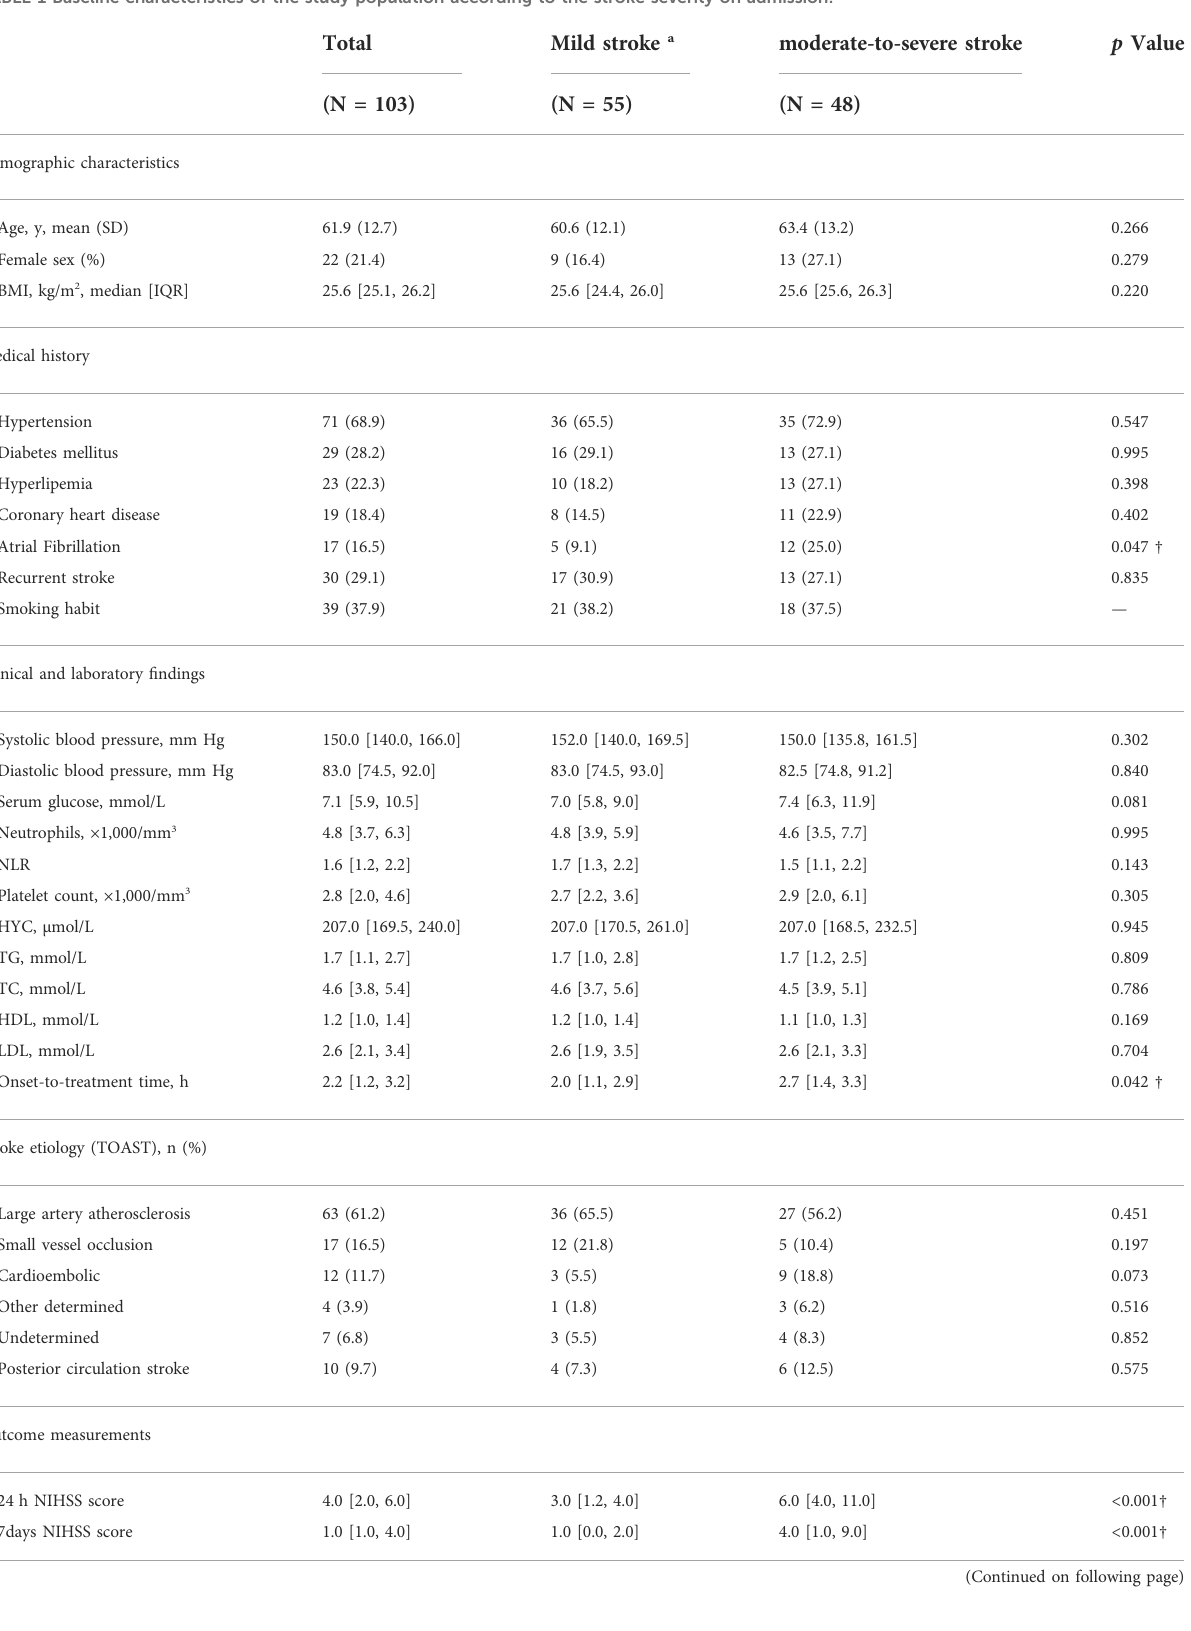
TABLE 1 Baseline characteristics of the study population according to the stroke severity on